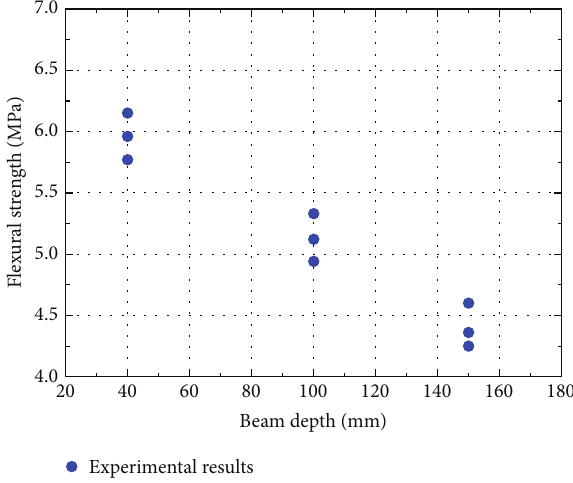
Figure 6: Influence of beam size on flexural strength of